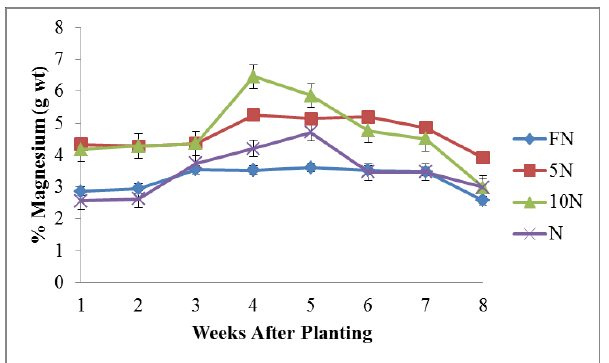
Fig. 7a. The effect of nitrogen nutritional stress on the percent- age magnesium content of Vigna unguiculata measured at dif- ferent periods